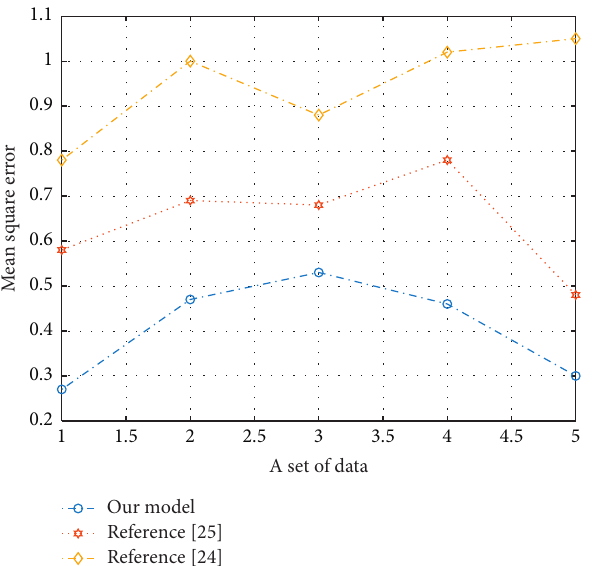
Figure 7: Mean square error of locations of different algorithms.